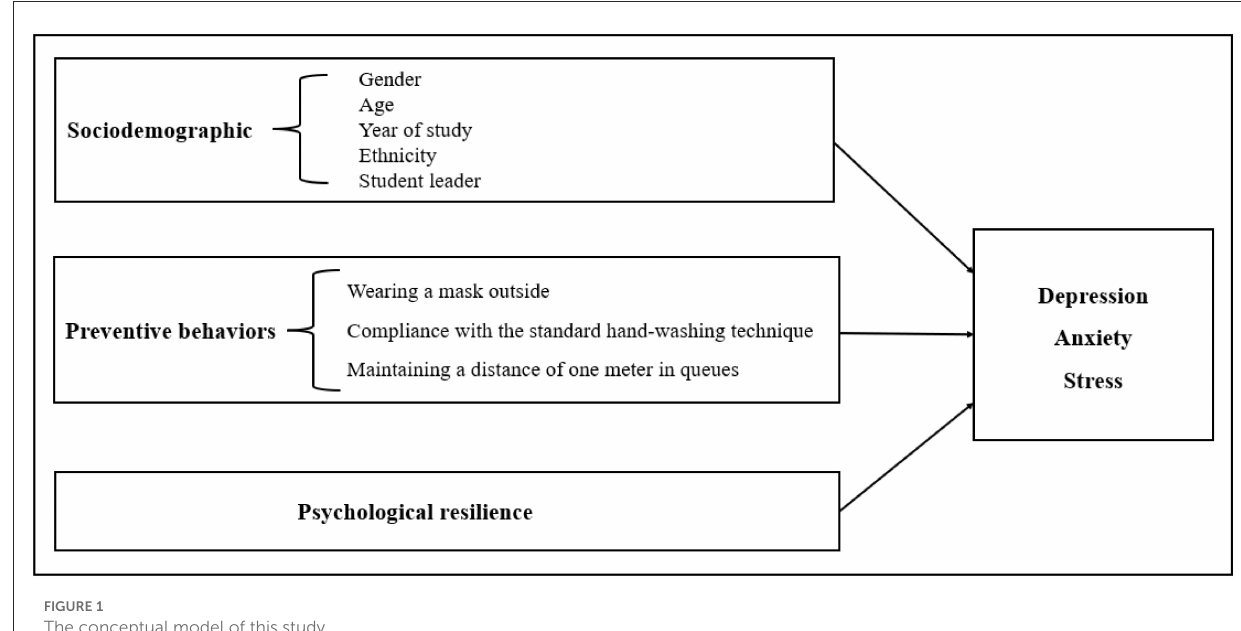
FIGURE1 The conceptual model of this